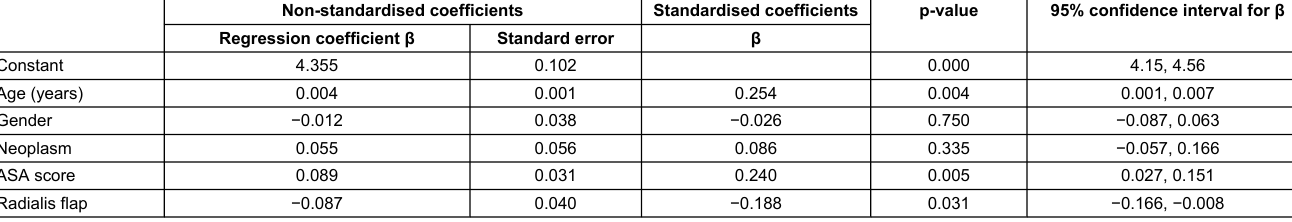
Table 6: Coefficients of linear regression with log costs (CHF) as the dependent variable (n =